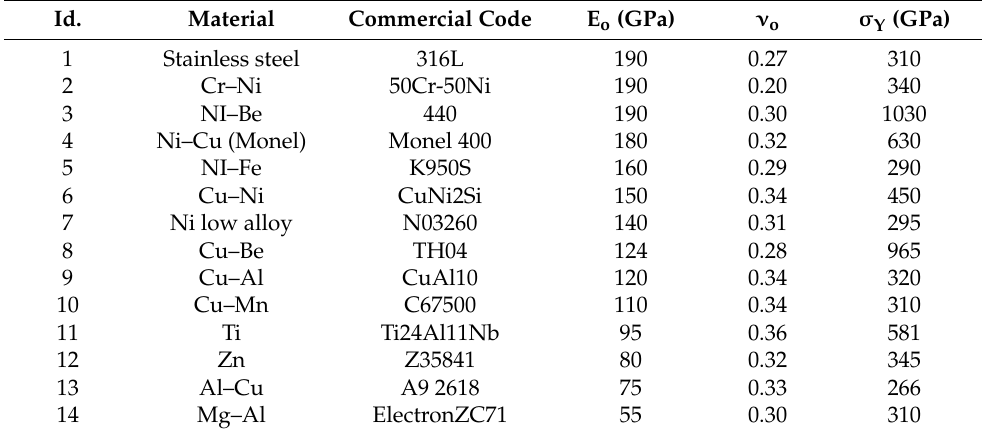
Table 1. Mechanical properties of the materials selected for the contact ring.